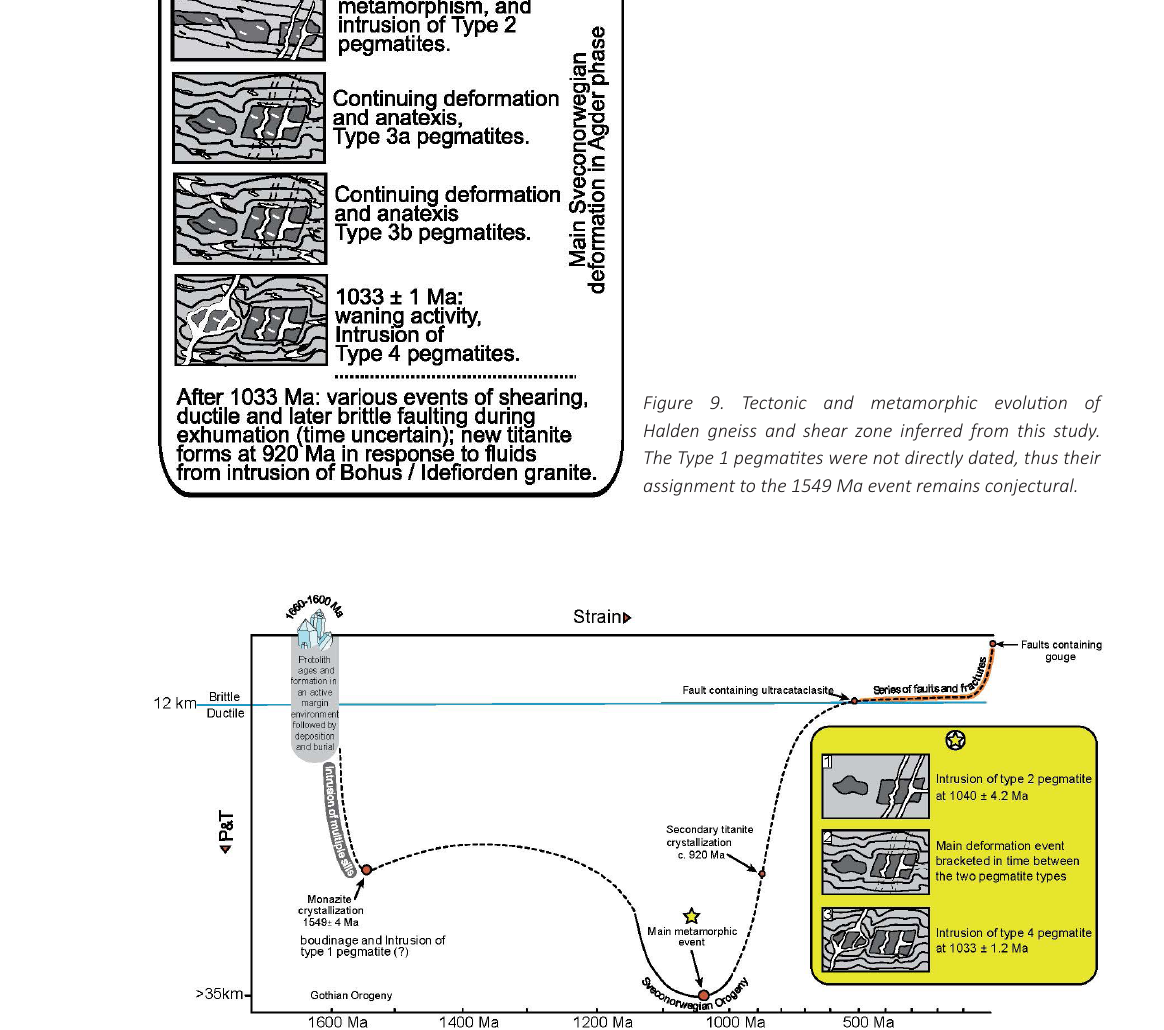
Figure 10. Thermo-tectonic history of the Østfold Gneiss Complex (modified from Narum,